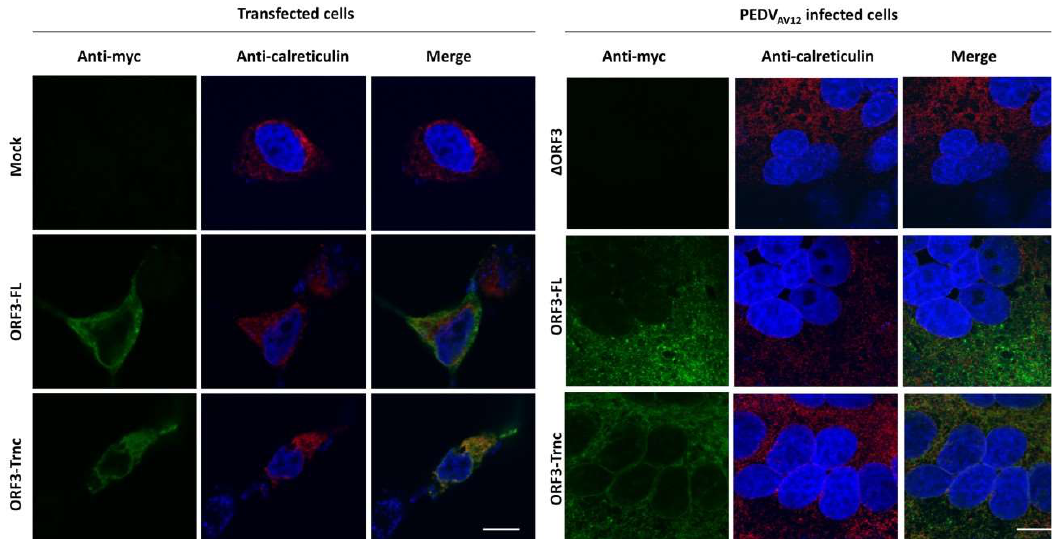
Figure 3. Subcellular localization of ORF3 in the endoplasmic reticulum (ER) of transfected and infected VeroE6 cells stably expressing porcine aminopeptidase N (VeroE6-APN). VeroE6-APN cells were transfected with pCAGGS_ORF3s-myc (ORF3-FL or-Trnc) ( left panel ) or infected by the PEDV AV12 _∆ORF3 and-ORF3s-myc (ORF3-FL or-Trnc) ( right panel ). Cells were stained with rabbit anti-myc and mouse anti-calreticulin ER marker as primary antibodies and goat anti-rabbit IgG Alexa flour 488 and-mouse IgG Alexa flour 647 as secondary antibodies. Nuclei were stained with Prolong Gold Antifade Mountant with DAPI. Co-localization of PEDV ORF3 protein with the ER marker was analyzed by confocal microscopy. Scale bars are 10 µm.